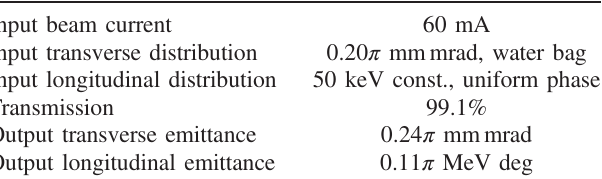
TABLE III. Simulation results of epRFQ.